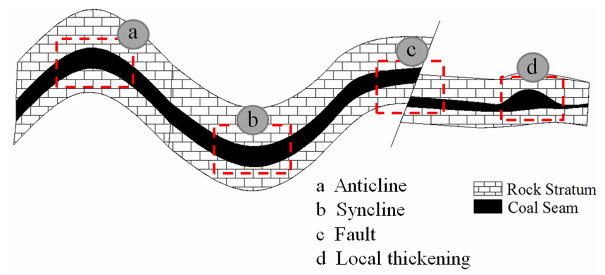
Figure 2. Abundant zones of coal gas in some geologic